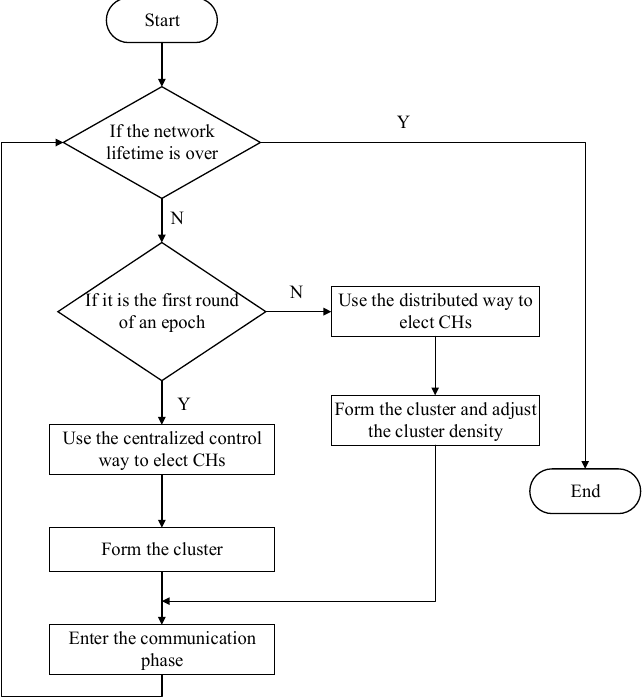
Figure 1. The process of the DAHC protocol.